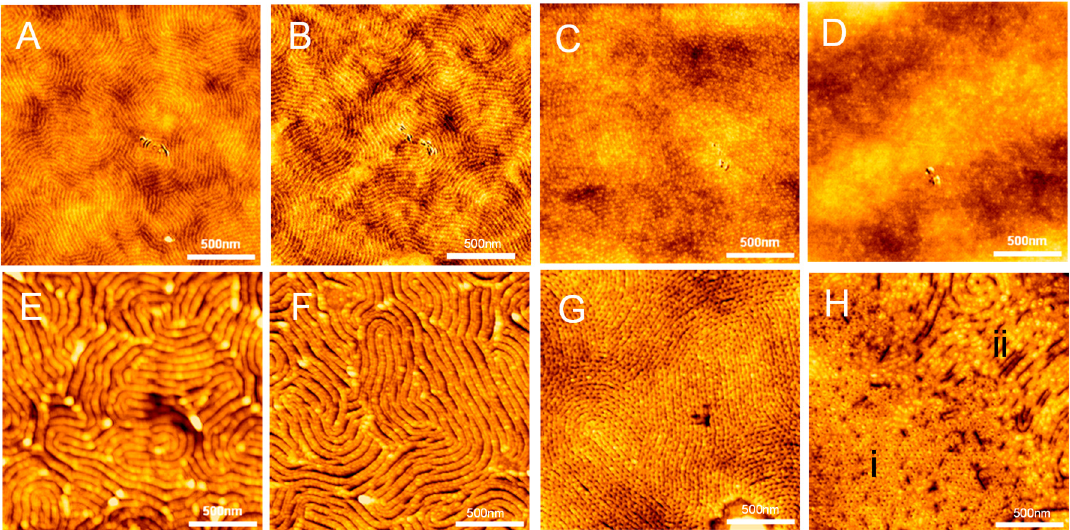
Figure 1. AFM topographic images of thin films (h i = 97 nm) of P(S 21 - b -M 21 )/PS 6 mixtures of various weight fractions: ( A , E ) 100/0, ( B , F ) 95/5, ( C , G ) 75/25 and ( D , H ) 50/50, respectively. The thin films were spin-coated on PS 270n -capped SiO x /Si substrates and then annealed at 230 ◦ C (1 h). Images A–D were collected for the films without a combination of UV-light exposure (2.5 h) and acetic acid rinsing. Images E–H were collected for the films through a combination of UV-light exposure (2.5 h) and acetic acid